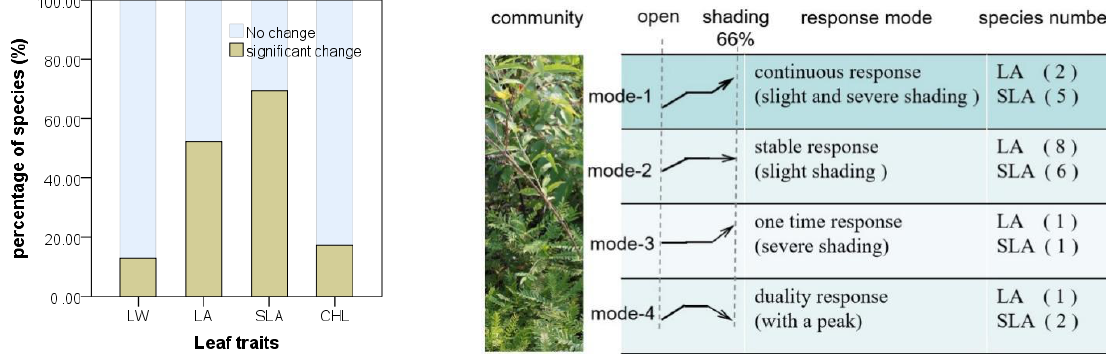
Figure 3. The percentage of plant species with significant changes and response modes in leaf traits following shading gradient changes. The total number of analyzed species here is 23 (n = 23). LW is the leaf shape index defined by the ratio of the length and width of the leaf, LA is the leaf area, SLA is the specific leaf area, and CHL is the chlorophyll concentration in the leaf measured as a SPAD value. Open and 66% shading represent controlled treatments and severe shading, respectively. Contents